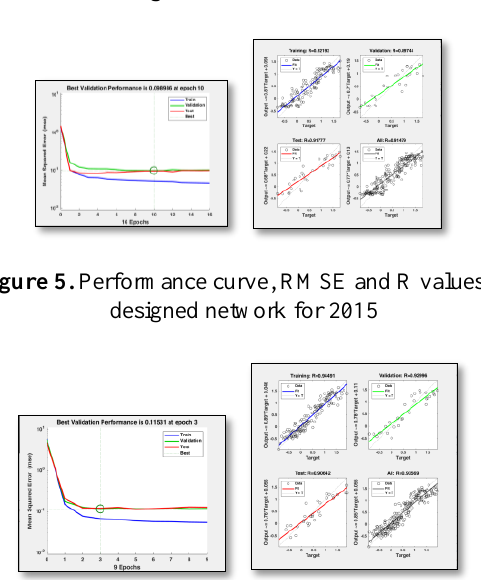
Figure 4. Performance curve, RMSE and R values of designed network for 2010